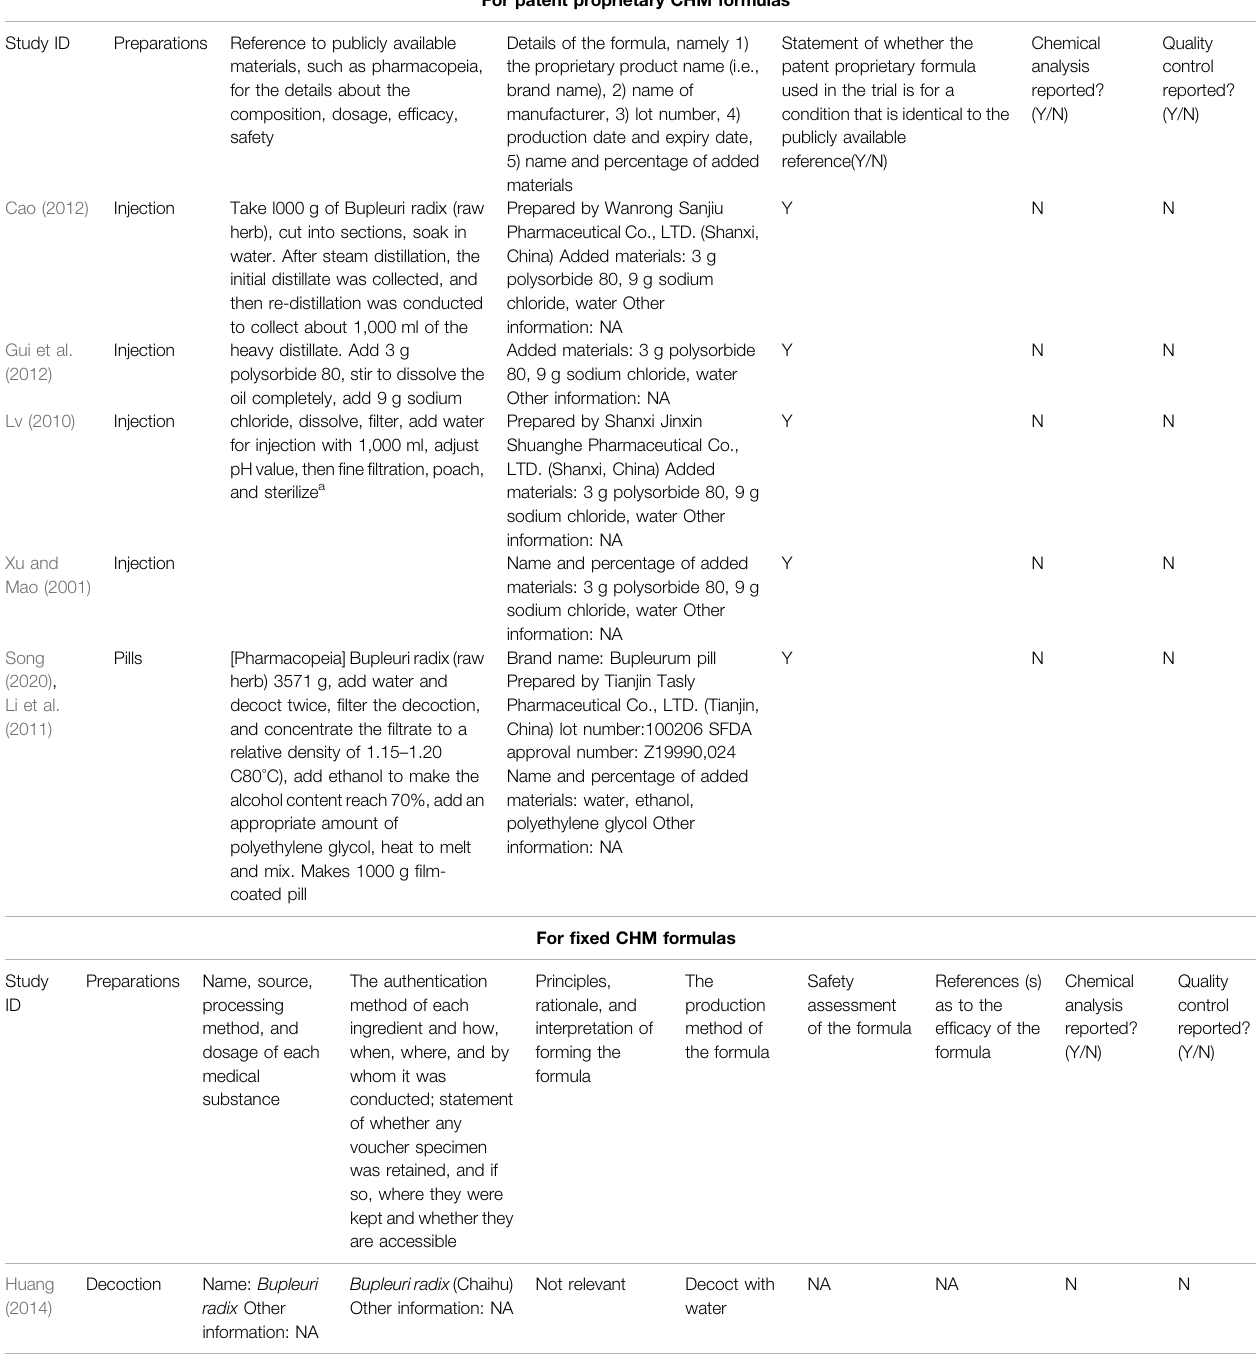
TABLE 2 | Details of Bupleuri radix preparations in the included